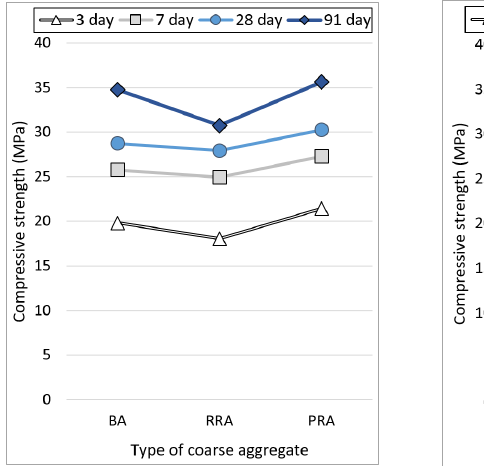
Figure 8. Compressive strength of the concrete.